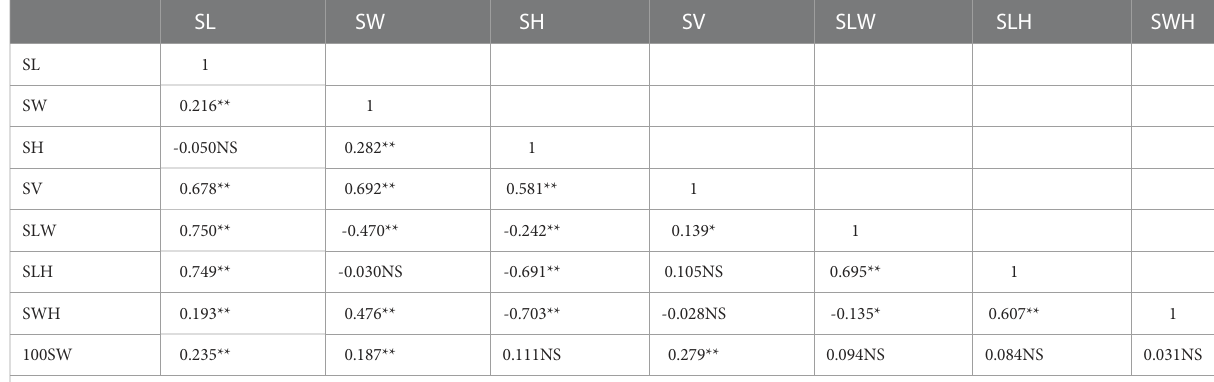
TABLE 2 Pearson phenotypic correlation coef fi cient among seed-related traits in F 2:3 population. SL SW SH SV SLW SLH